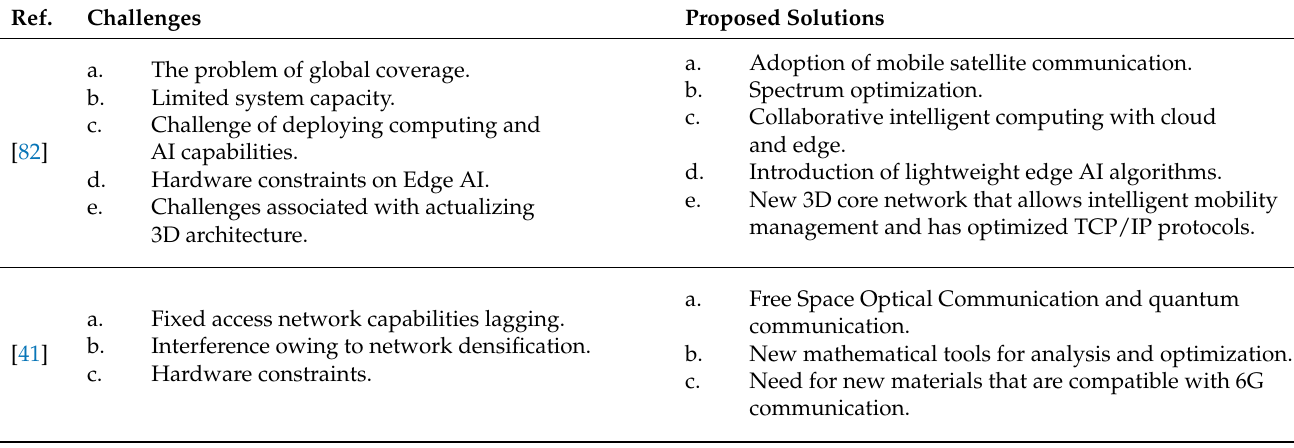
Table 18. 6G standardization, design, and deployment challenges and proposed solutions.